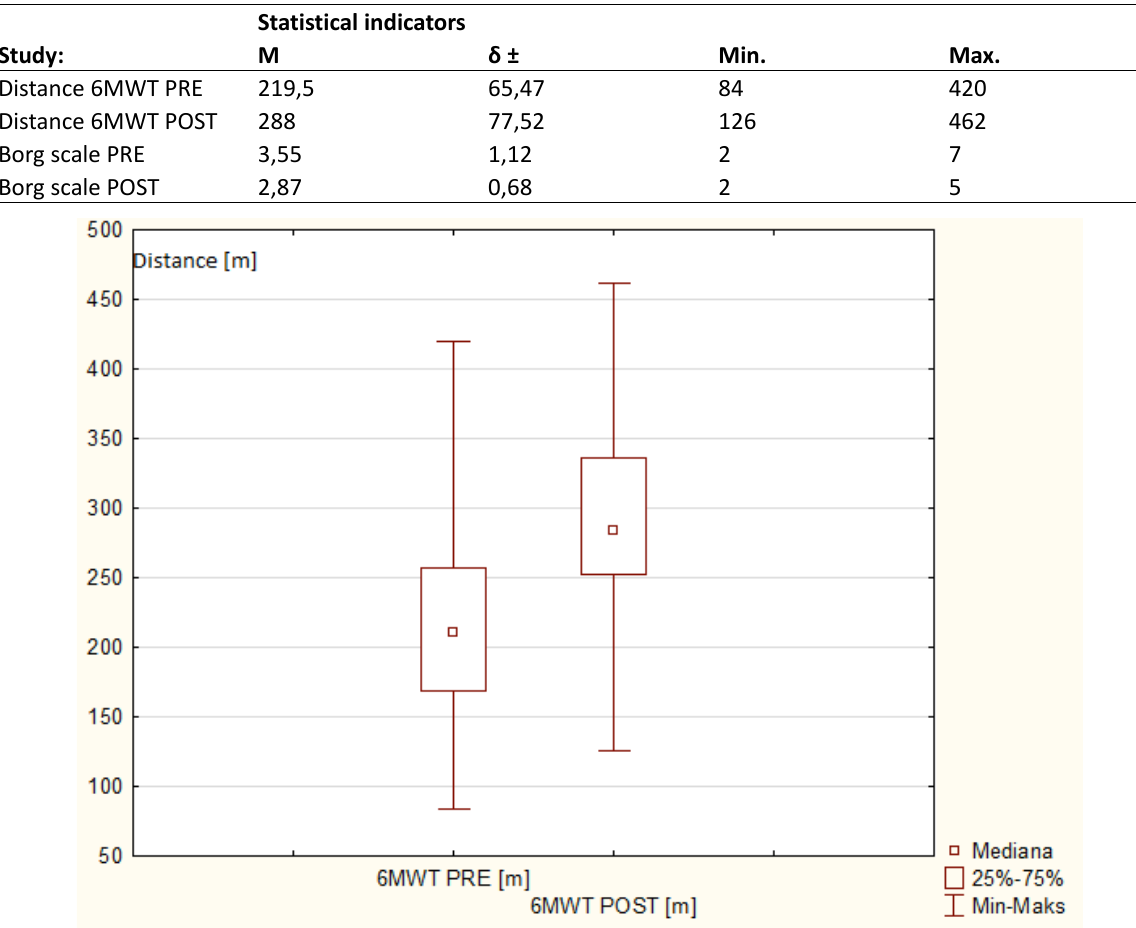
Figure 1. Distribution of results in 6MWT before and after a cycle of